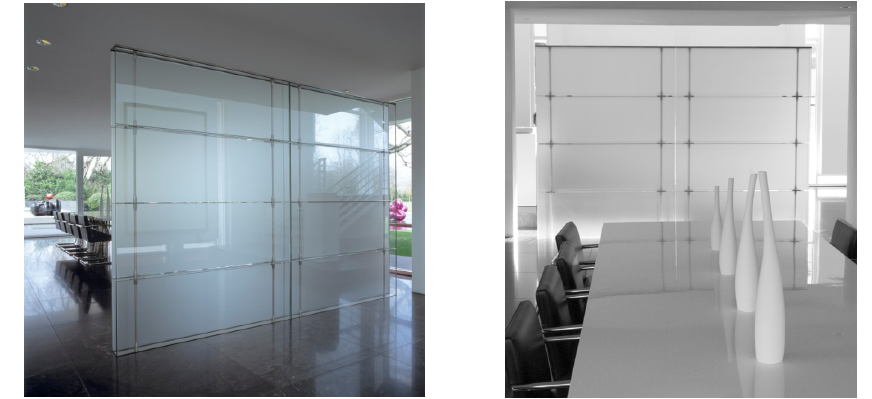
Figure 3a, b: View from the gallery (a) and from the dining room